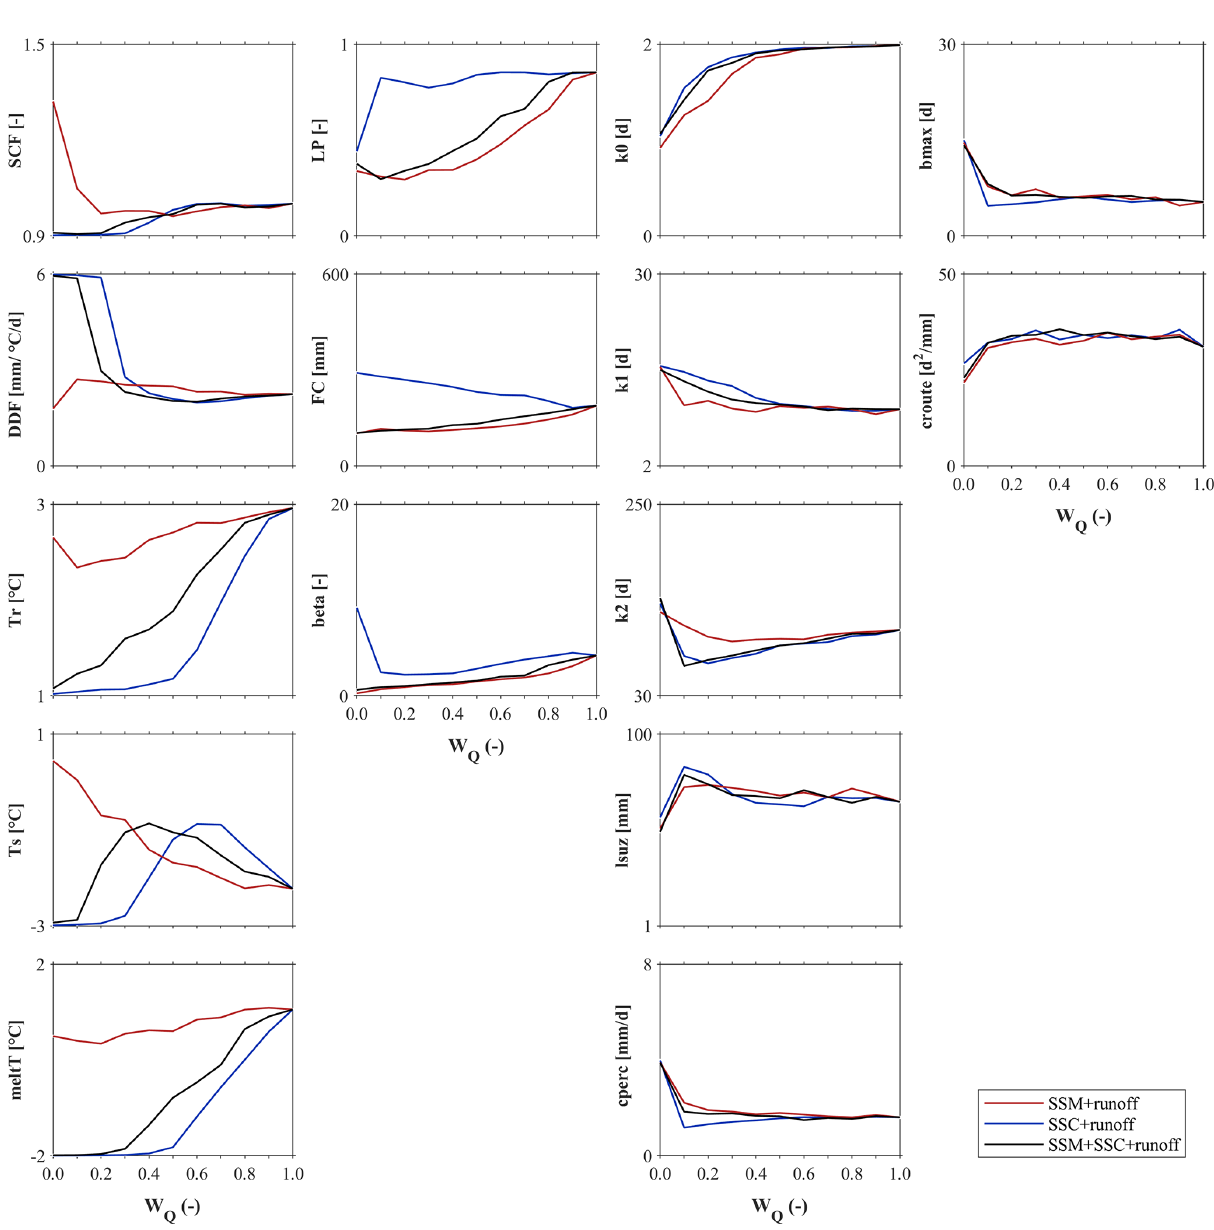
Figure 7. Medians of the parameter values from the three multiple objective calibration variants (lines) and different runoff weights w Q (Table 3). Red, blue, and gray lines represent the calibration variants using soil moisture and runoff, snow cover and runoff, and soil moisture, snow cover data, and runoff, respectively. Lines represent the median of the 213 Austrian